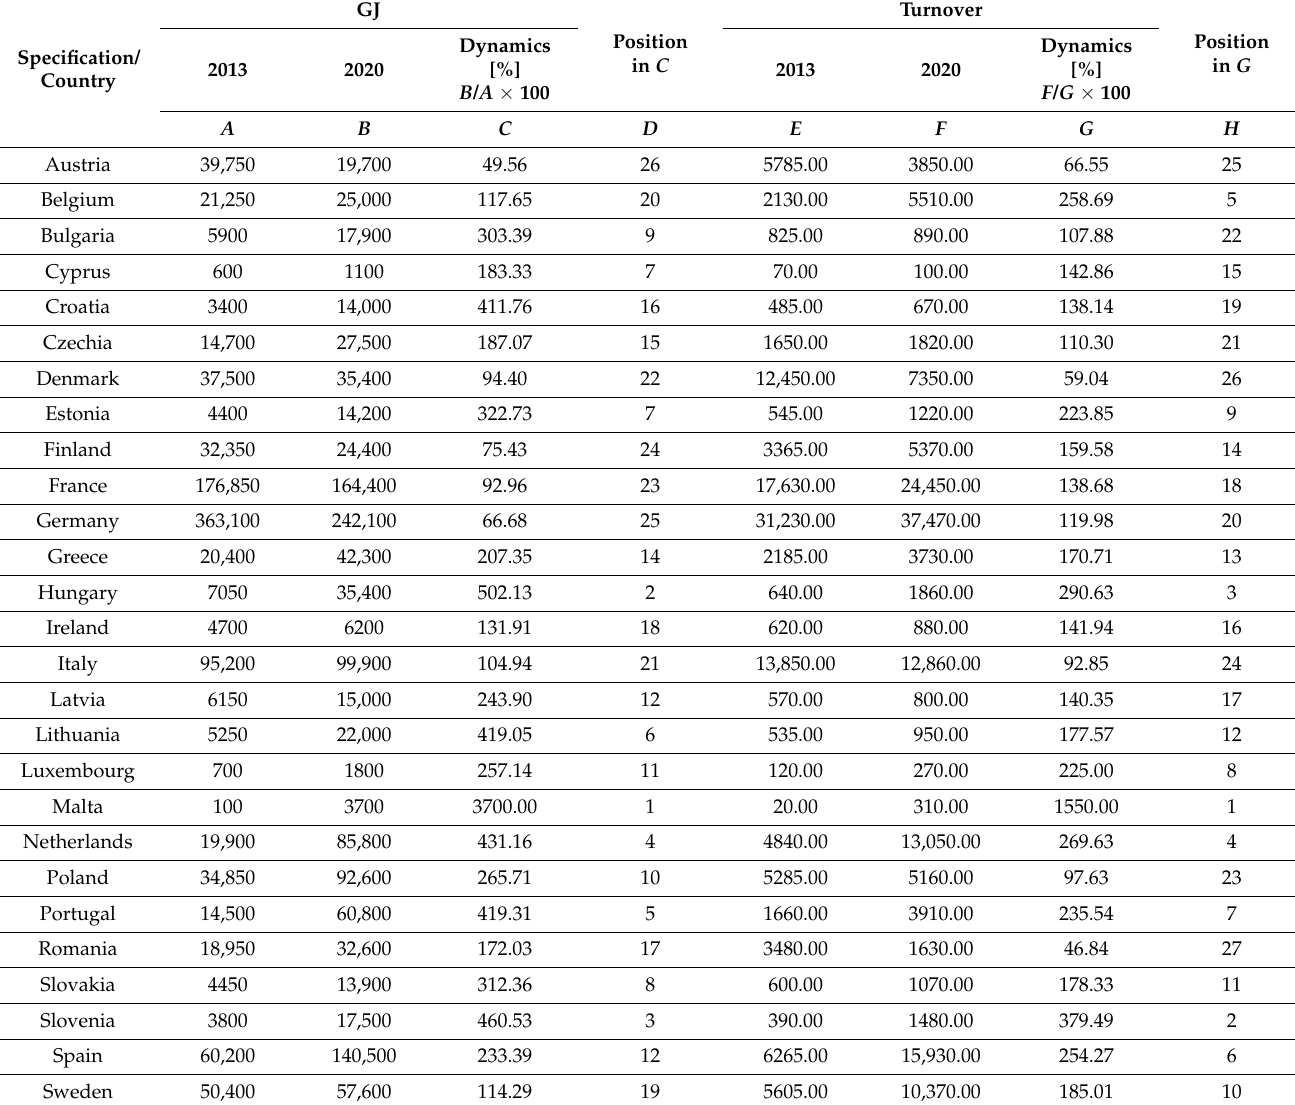
Table A1. GJ in the RES sector (number of people employed) and the volume of turnover in the RES sector (in million euros)—comparison of 2013 and 2020 in the EU-27